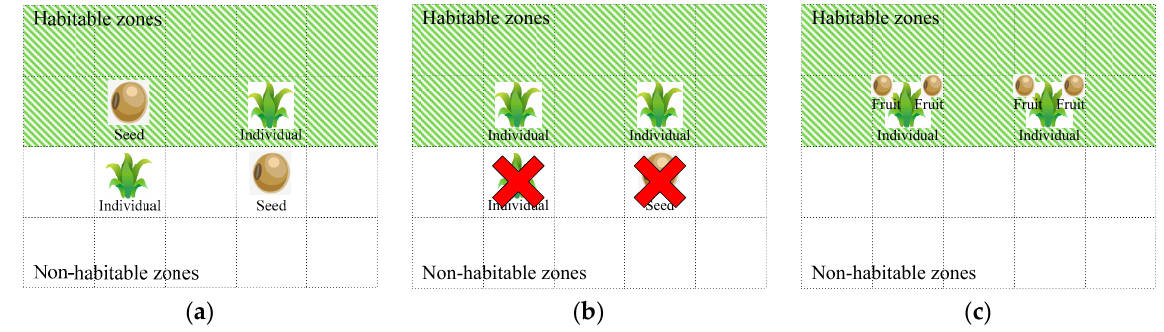
Figure 1. Arti fi cial plant community system [27,46]: ( a ) seeding; ( b ) growing; ( c )